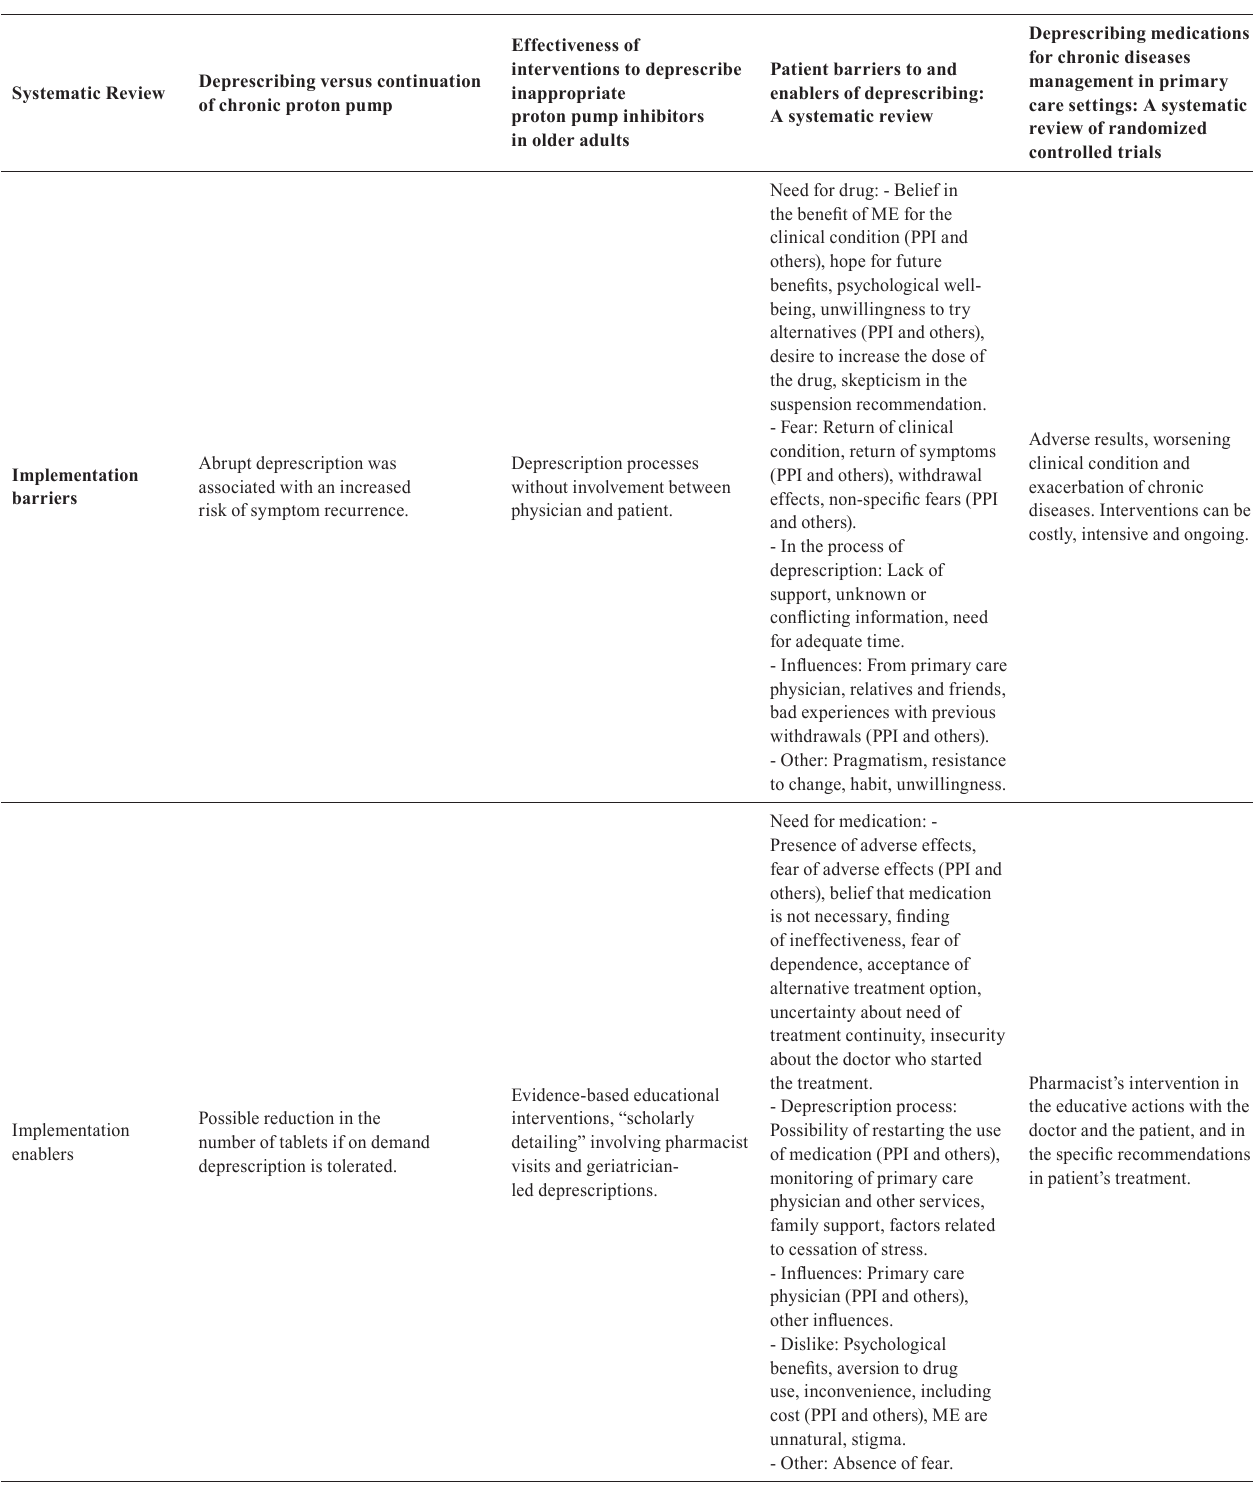
TABLE II - Characteristics of the included studies